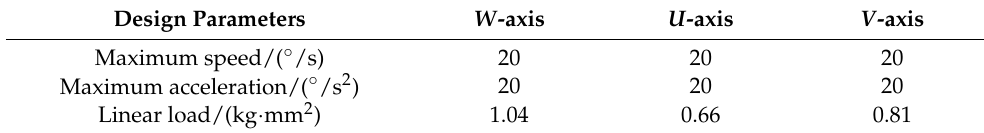
Table 3. Main parameters of the three-axis rotary table. Design